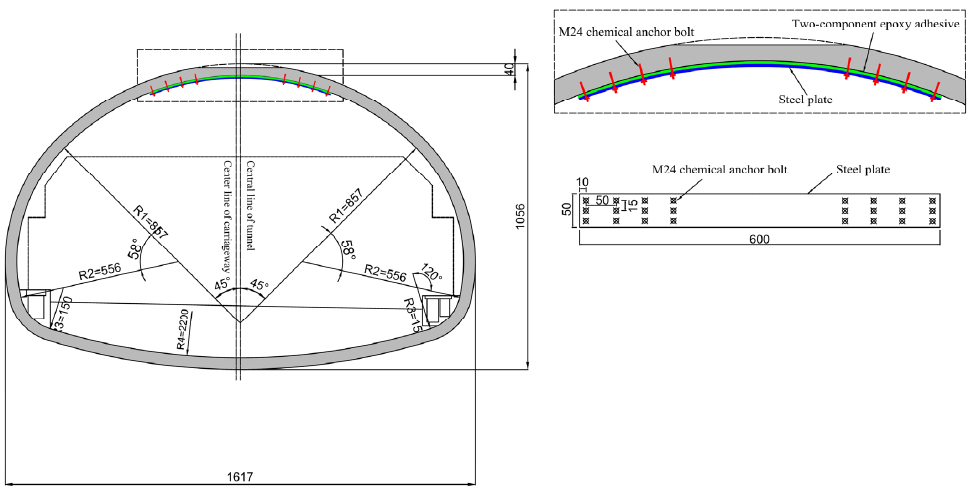
Figure 1. Transverse section and strengthening scheme of the studied tunnel.